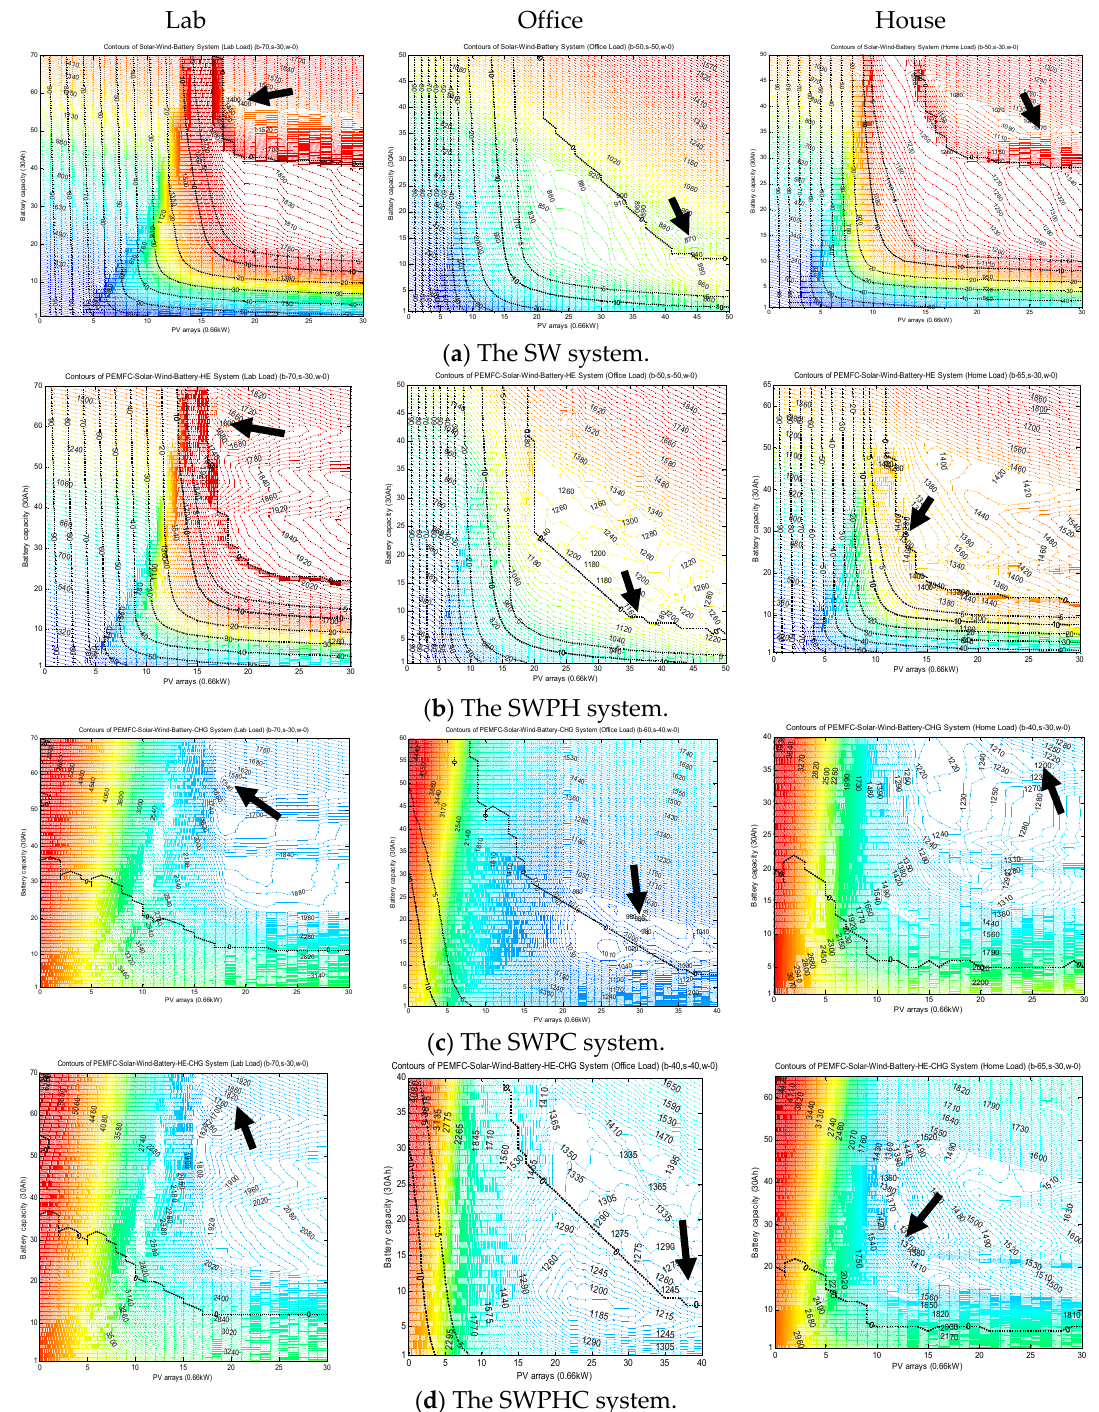
Figure 9. Reference plots of four hybrid power models.